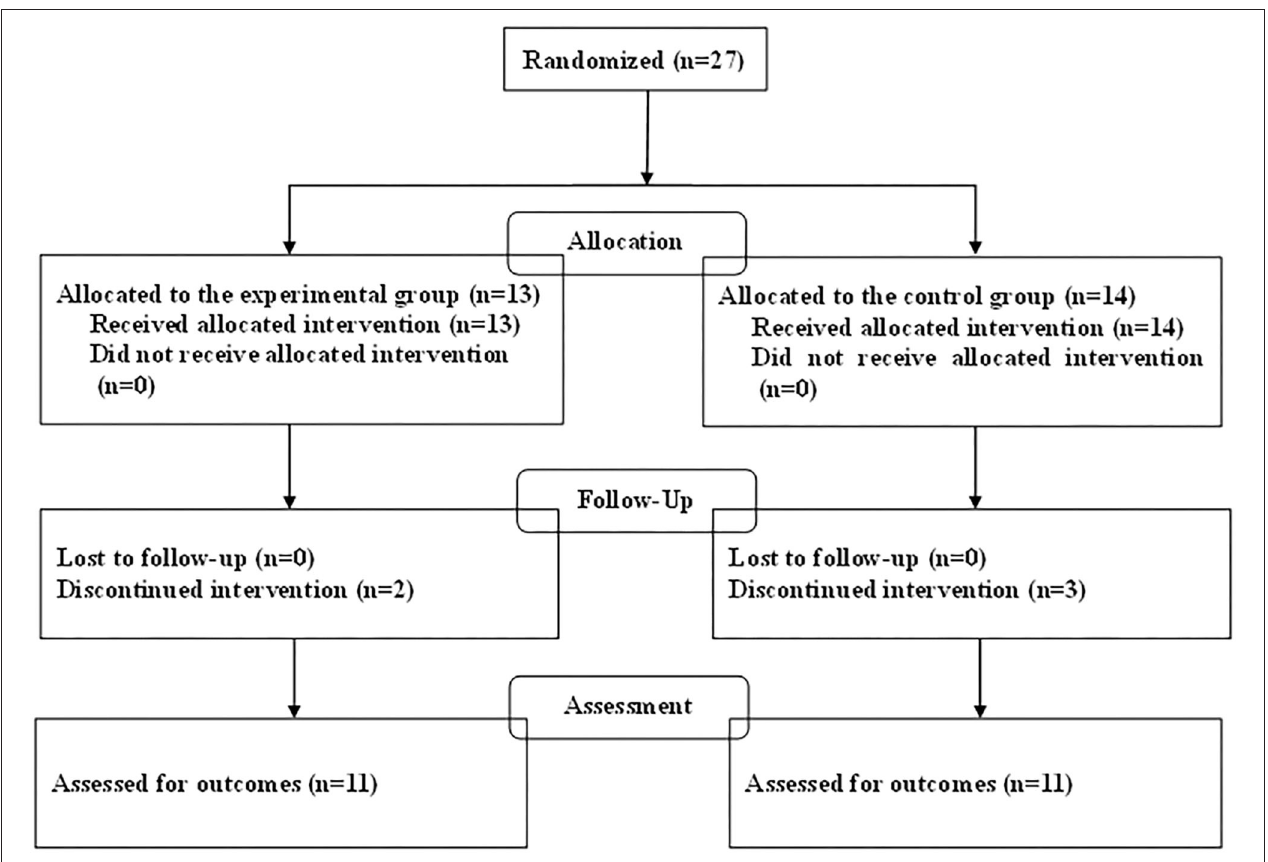
FIGURE 1 | Enrollment flowchart following CONSORT